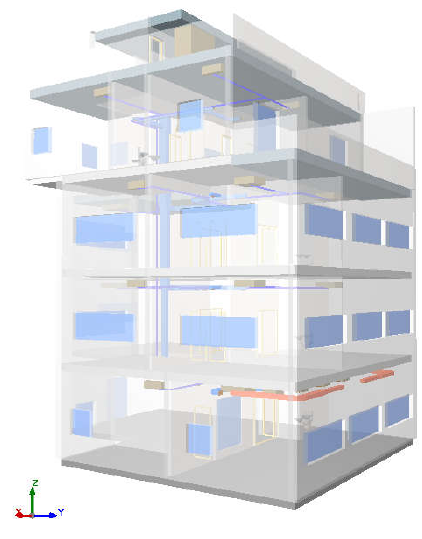
Figure 6. Office building 3D-model.